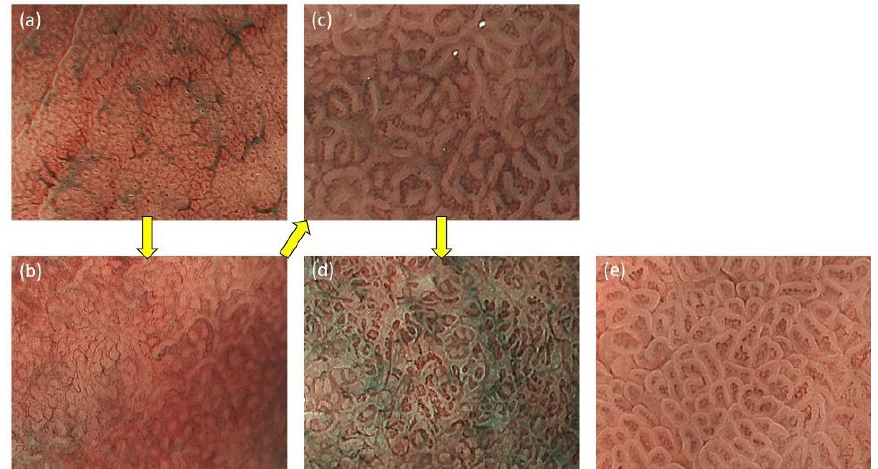
Figure 2. ( a ) The fundic gland mucosa without inflammation. The glandular structures are regularly arranged in a mesh pattern; ( b ) The glandular structure is still circular, but gradually becomes ir- regular in size and shape; ( c ) The circular glandular structures gradually disappear and tubular glandular structures are observed; ( d ) Gastric fundic glands disappear and glandular structure re- sembles that of pyloric glands; ( e ) The pyloric gland mucosa without inflammation. ME-NBI of intestinal metaplasia shows a blue-white border at the limbus of the WZ. This was reported as a light blue crest by Uedo et al. and is thought to represent the dif- ference in reflectance characteristics caused by the projection of 415 nm narrow-band light onto the brush border of intestinal metaplasia (Figure 3) [12].